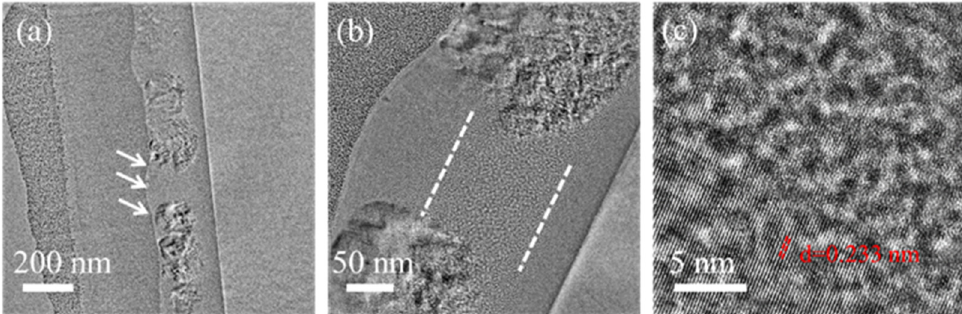
Figure 5. TEM images of the N–A TiAl film with a helium implantation fluence of 2 × 10 17 ions cm − 2 . ( a ) Low magni fi cation bright fi eld image; ( b ) high magni fi cation bright fi eld image; and ( c ) HRTEM image.